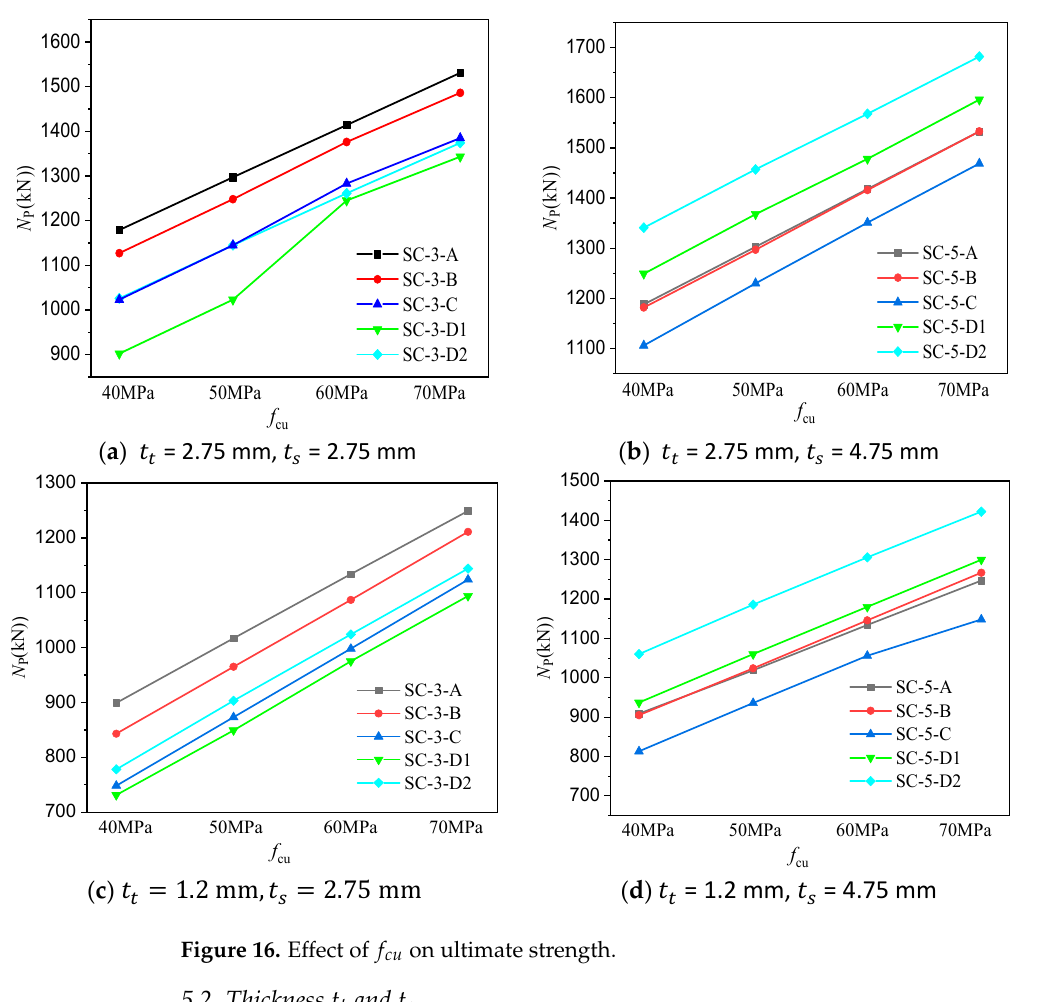
Figure 16. Effect of 𝑓 (cid:3030)(cid:3048) on ultimate